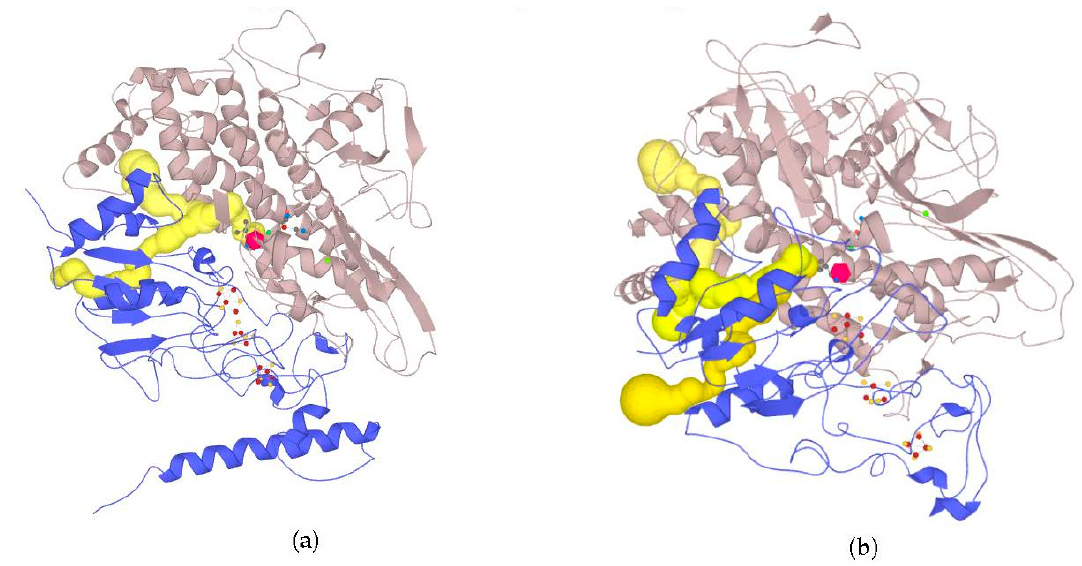
Figure 12. Tunnel structure in some of the studied hydrogenases. ( a ) HupSL from Rsp. rubrum ; (data available online: https://mole.upol.cz/online/U1IDaUXAtk9G2dt1a54w/1); ( b ) HoxKG hydrogenase from R/eutropha (PDB ID: 3RGW); the most important gas channels (starting in the points close to active site) are colored yellow (data available online: https://mole.upol.cz/online/ORQHeeJ90OSUp1FWnBFlg/1); the red polyhedron indicates V77, one of the first lining residues of the tunnels close to the active site. The nickel atom is colored dark-green.